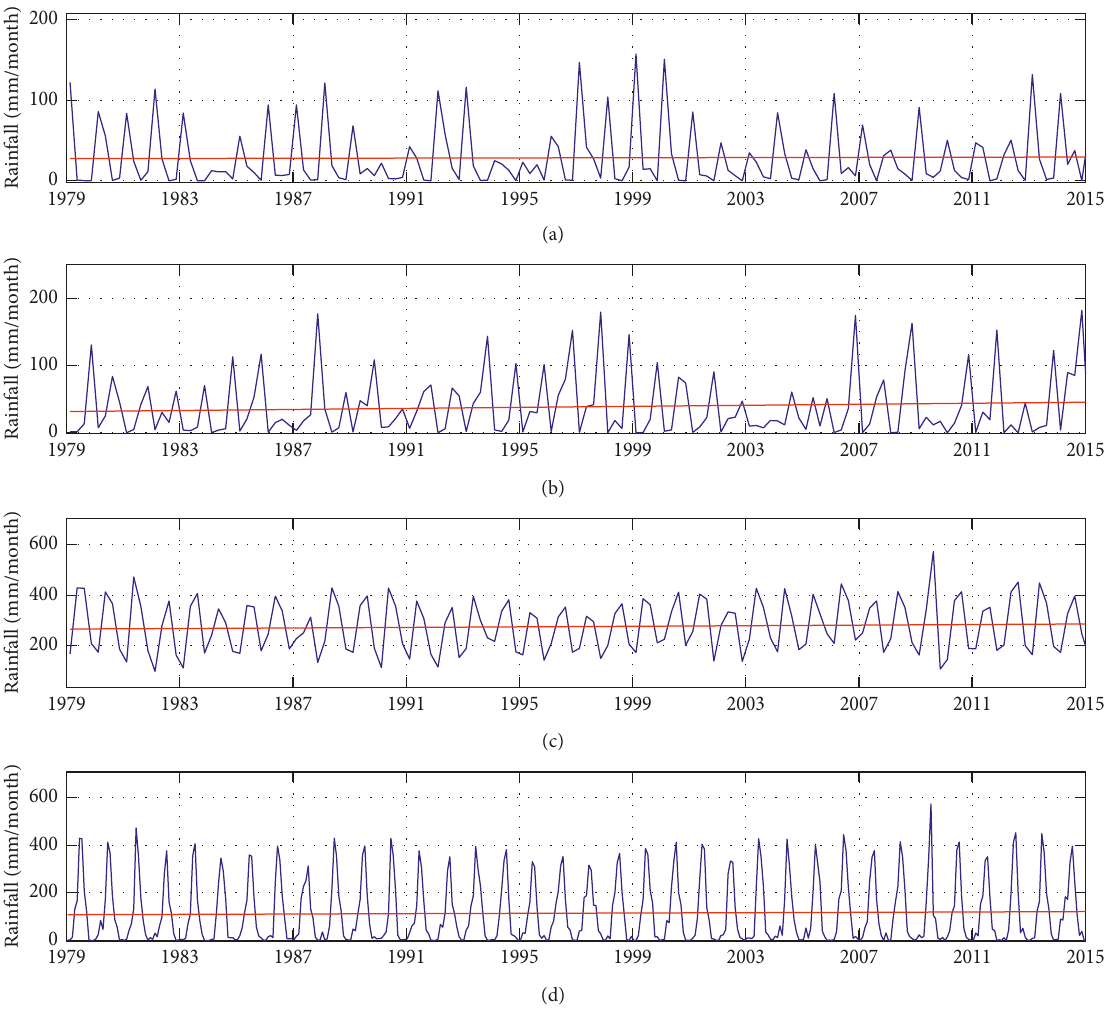
Figure 4: Rainfall trend of the Lake Tana basin at a significance level of 95% confidence interval: (a) LTB rainfall trend (slope Bega (ONDJ); (b) LTB rainfall trend (slope 0.39) during Belg (FMAM); (c) LTB rainfall trend (slope (cid:31) rainfall trend (slope 0.36) for (cid:31)